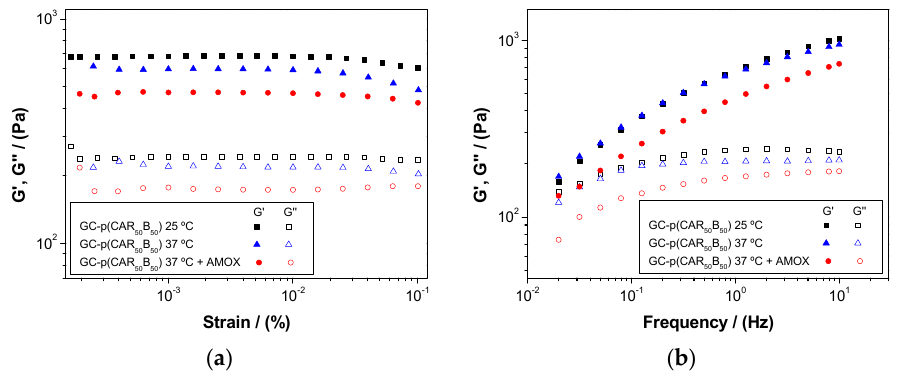
Figure 9. ( a ) Strain sweep tests of the different systems evaluated: GG ‐ p(CAR 50 B 50 ), at 25 and 37 °C, and the formulation of AMOX + GG ‐ p(CAR 50 B 50 ). ( b ) Frequency sweep tests of the different systems evaluated: GG ‐ p(CAR 50 B 50 ), at 25 °C and 37 °C, and the formulation of AMOX + GG ‐ p(CAR 50 B 50 ). SEM observations of the networks formed confirmed the super ‐ porous structure of the three systems, as can be observed in Figure 10. Analysis with FIJI Image ‐ J software revealed that every sample had a similar percentage of porosity (between 22% and 29%), not finding significant differences. Although pore size was heterogeneous within every sample, their mean pore diameters were ca . 0.290 μ m for all the samples (0.290 μ m for [GG-p(TAR 50 B 50 )], 0.294 µ m for [GG-p(CAR 50 B 50 )], and 0.288 µ m [GG-pB]).